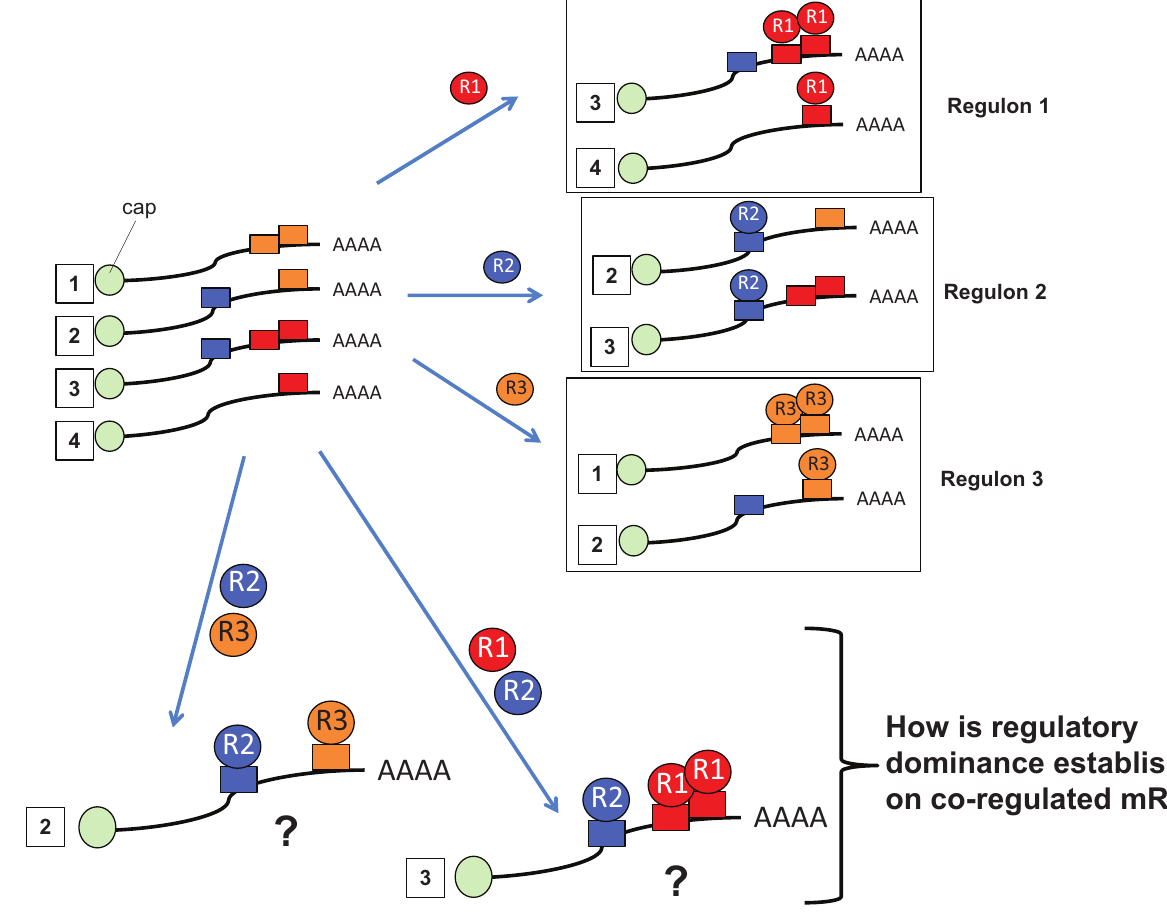
Figure 1. Coordinated control of mRNA subsets. The four cytoplasmic mRNAs shown (labeled with numbered white squares) form three RNA regulons that are determined by the binding of RBPs (labeled R1, R2 and R3) to specific sequence elements within the mRNAs. These interactions lead to co-regulation of distinct mRNAs within each RNA regulon (adapted from [35]). The fate of co-regulated, co-occupied mRNAs is less clear when mRNAs possess binding sites for multiple RBPs with antagonistic action (e.g., bound by both R1 and R2 concurrently (mRNA 3) or R2 and R3 (mRNA